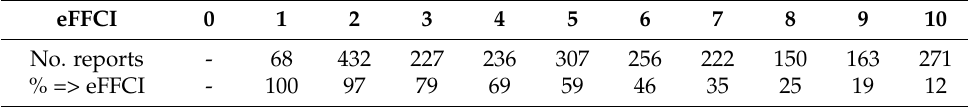
Table 7. eFFCI distribution of Ecuador historical flood events.